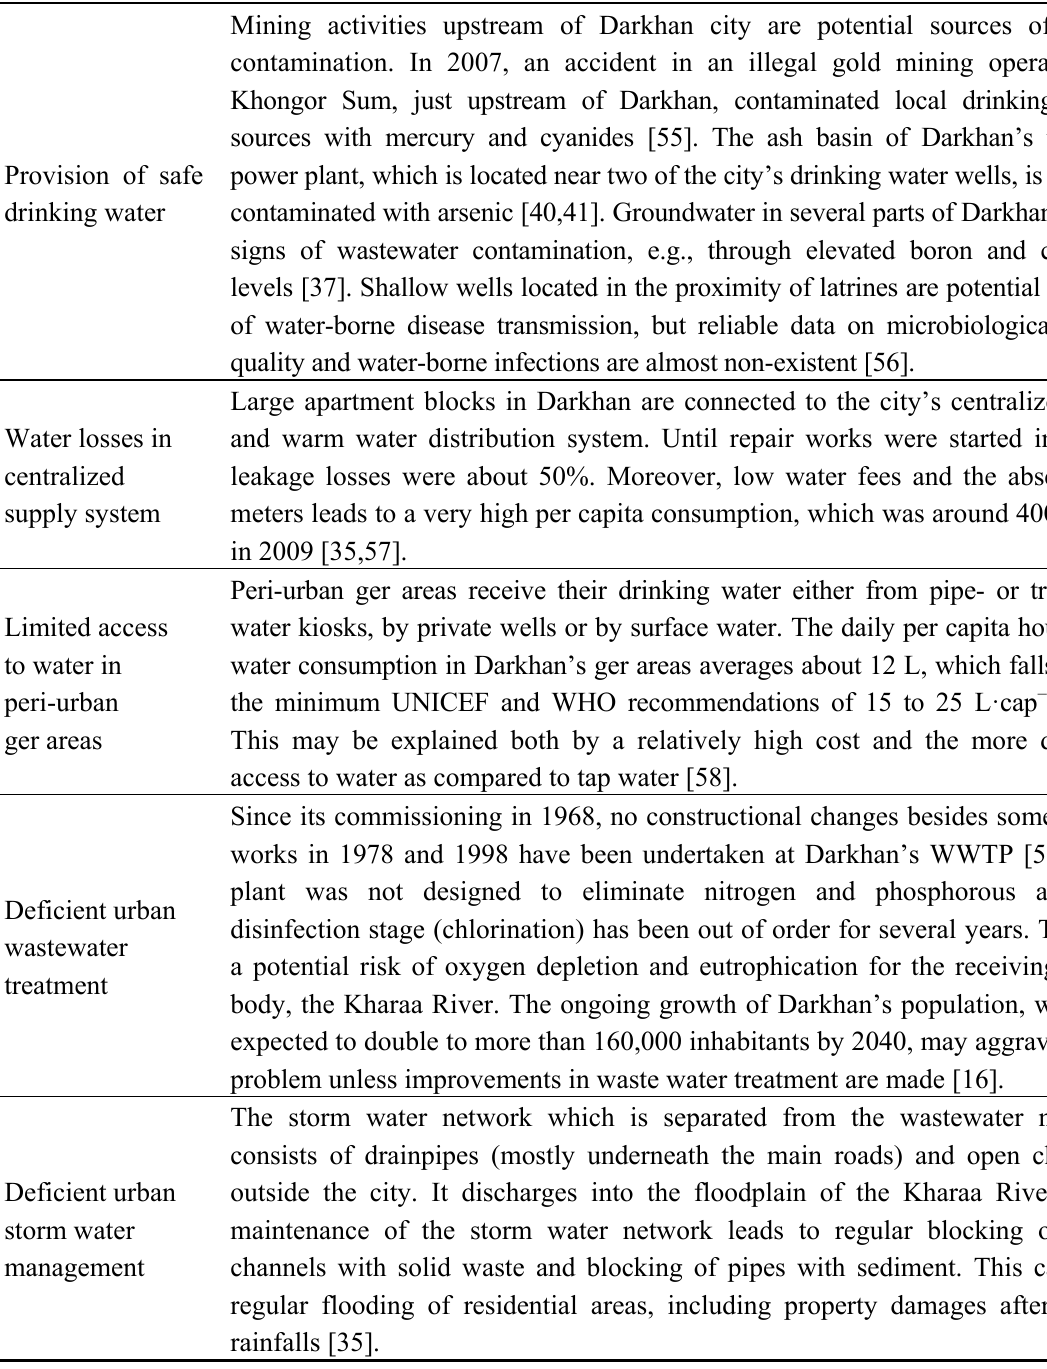
Table 1. Urban Water Management Challenges in